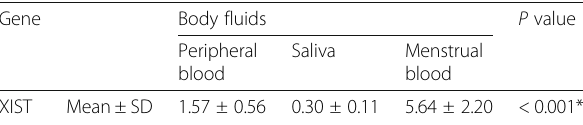
Table 2 Expression of XIST and RPS4Y1 in the studied body fluids of male and female participants